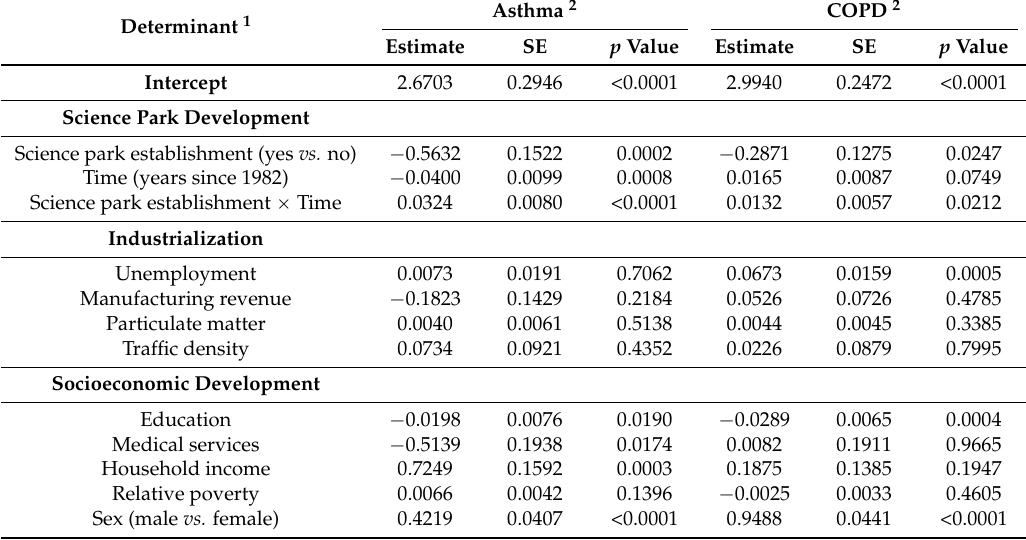
Table 5. Estimated fixed effects of determinants on city- and county-level respiratory mortality